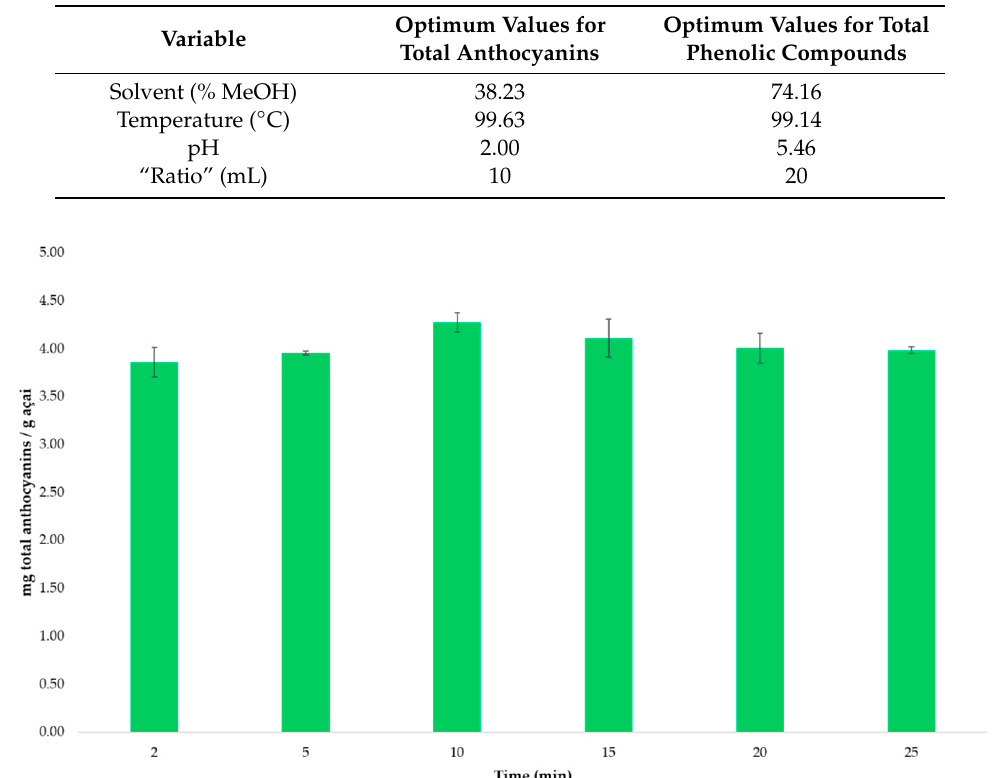
Table 2. The optimum conditions from MAE for anthocyanins and total phenolic compounds.